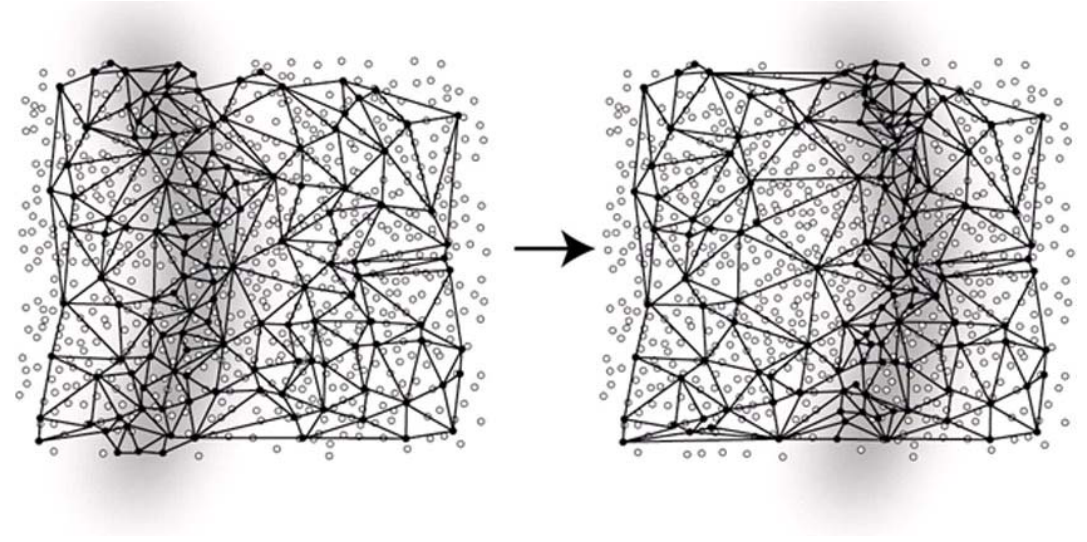
Figure 2. Tracking continuous phenomena over space and time using geosensor